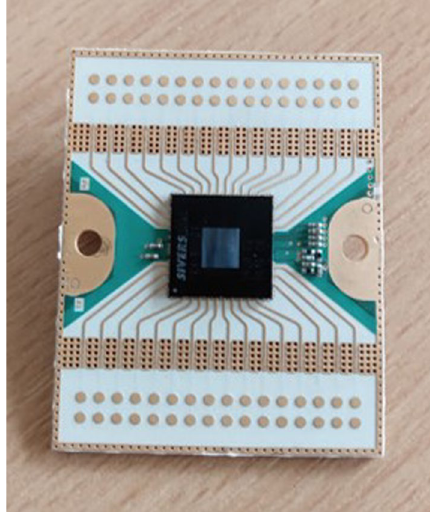
Fig. 12 2 × 16 PCB antenna arrays integrated with eWLB packaged transceiver. The PCB size is 50 × 40 mm